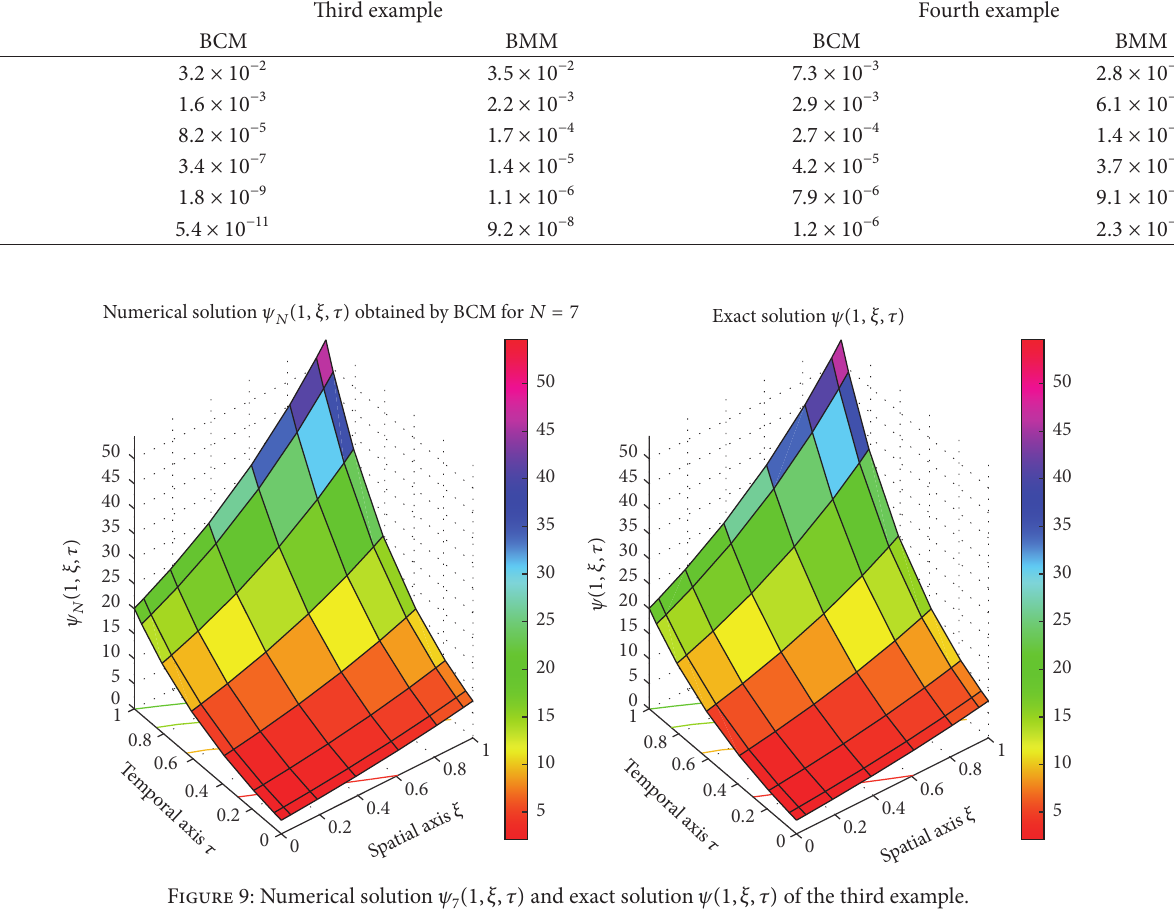
Figure 9: Numerical solution 𝜓 7 (1, 𝜉,𝜏) and exact solution 𝜓(1,𝜉, 𝜏) of the third example.